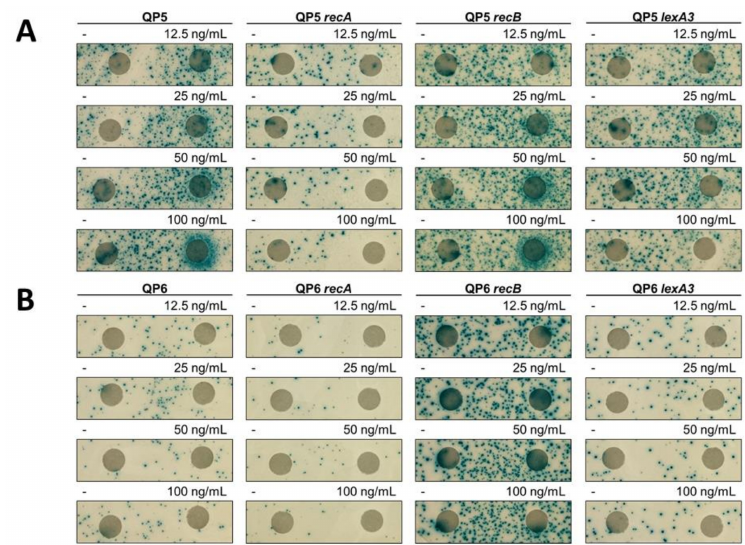
Figure 7. Mutator effect of ciprofloxacin. Disk diffusion assay for Lac reversion using QP5 ( A ) and QP6 ( B ) reporters ± recA , recB , lexA3 and lactose X-gal papillation medium. Each disk on the right was saturated with 5 µ L of ciprofloxacin at the indicated concentrations. The control disk on the left was spotted with 5 µ L of water.